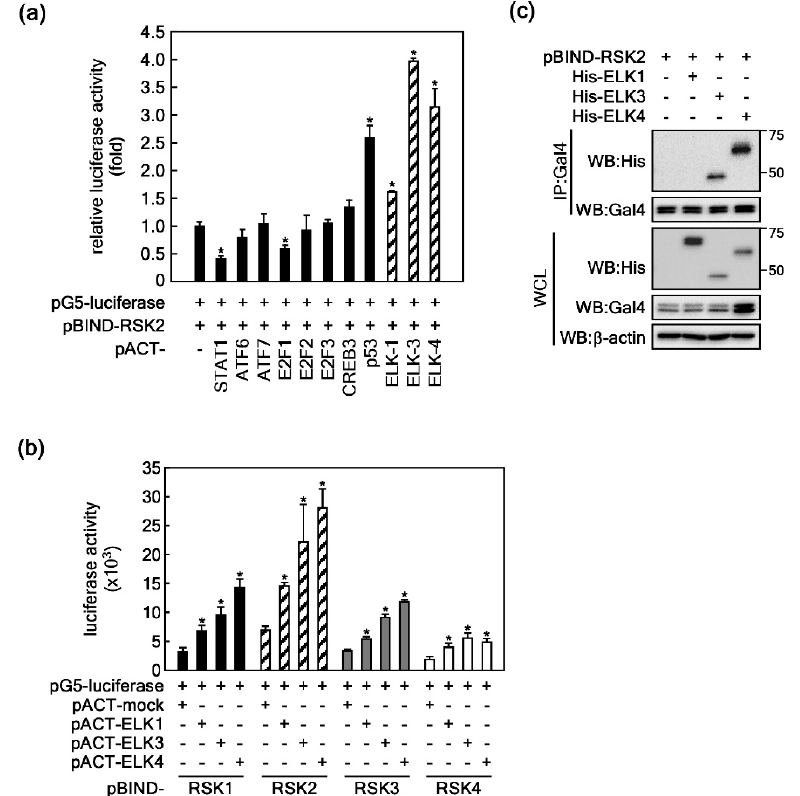
Figure 1. Ribosomal S6 kinase 2 (RSK2) is a novel ELK binding partner. ( a ) Mammalian two-hybrid assay. At the same molar ratio, each of 29 transcription factors cloned in pACT mammalian two-hybrid vectors was introduced into HEK293T cells with pBIND-RSK2 and pG5-luciferase reporter plasmid in wells of 48-well plates. The total amount of the three vectors did not exceed 100 ng. Firefly luciferase activity was normalized to Renilla luciferase activity. Data were obtained from three independent experiments, and values are presented are means ± SEM. * p < 0.01 versus pACT-mock control cells (Student’s t -test). ( b ) Comparison of binding affinity of ELKs with RSKs. At the same molar ratio, each ELK1, 3, and 4 in pACT, and each RSK1, 2, 3, and 4 in the pBIND mammalian two- hybrid vectors was introduced into HEK293T cells with pG5-luciferase reporter plasmid into wells of 48-well plates. Firefly luciferase activity was normalized to Renilla luciferase activity. Data were